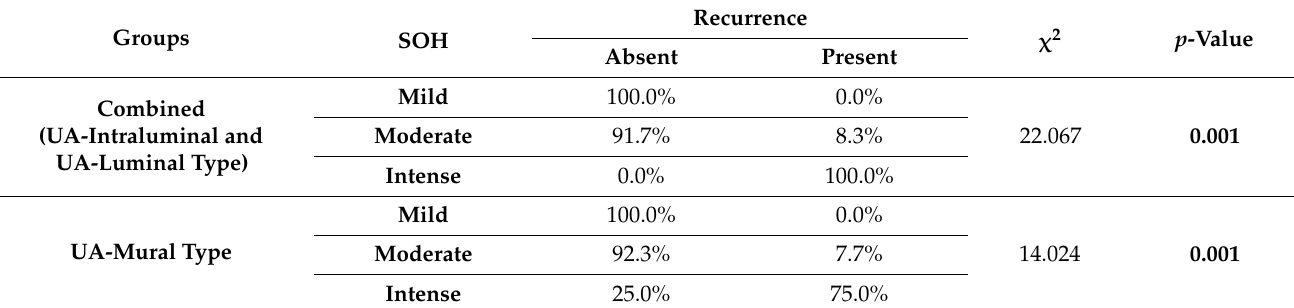
Figure 1. Comparison of correlation of SOH with recurrence of unicystic ameloblastoma. It was observed that both variants (UA-IL/UA-L vs. UA-M) showed strong statistical correlation between SOH and recurrence ( p = 0.001), Table 3 and Figure 2. Table 3. Comparison of correlation of SOH with recurrence of UA—subgroups.